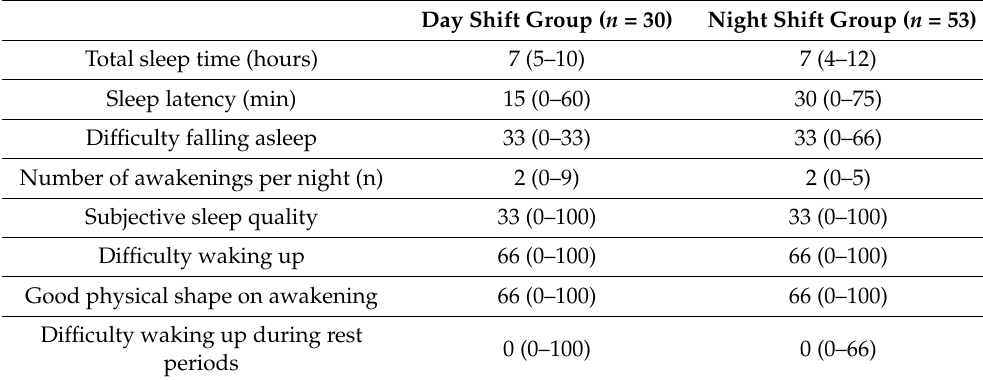
Table 1. Median (range) scores for sleep disorders, as reported by the day shift and night shift groups. None of the intergroup differences were statistically significant. The scores were assessed on a scale graduated in four quarters from 0 (very good) to 100 (very bad). Please refer to the text for details. The higher the score, the lower the quality of the sleep or the waking-up status.